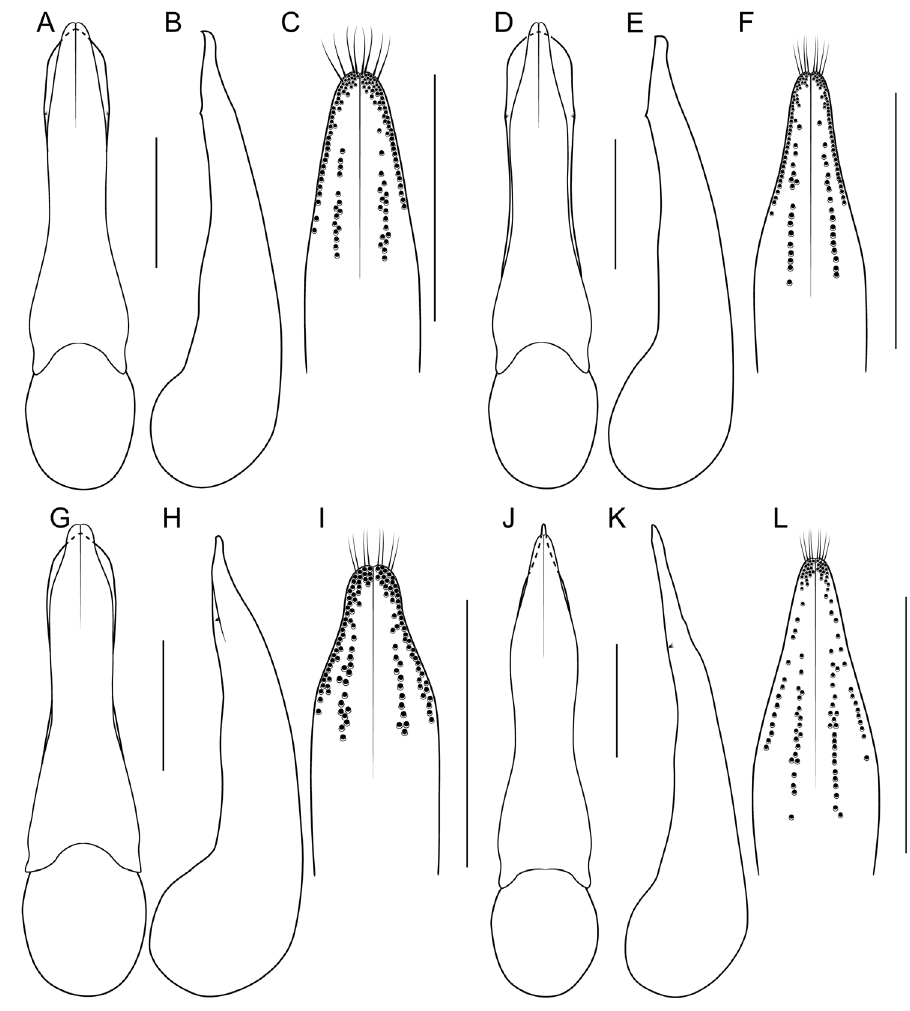
Figure 14. Bolitogyrus pictus Smetana & Zheng ( A–C ), B. schillhammeri Brunke ( D–F ), B. rougemonti Brunke ( G–I ) and B. profundus Cai et al. ( J–L ). Aedeagus in parameral view ( A, D, G, J ), median lobe in lateral view ( B, E, H, K ), peg setae of paramere ( C, F, I, L ). Scale bars: 0.5